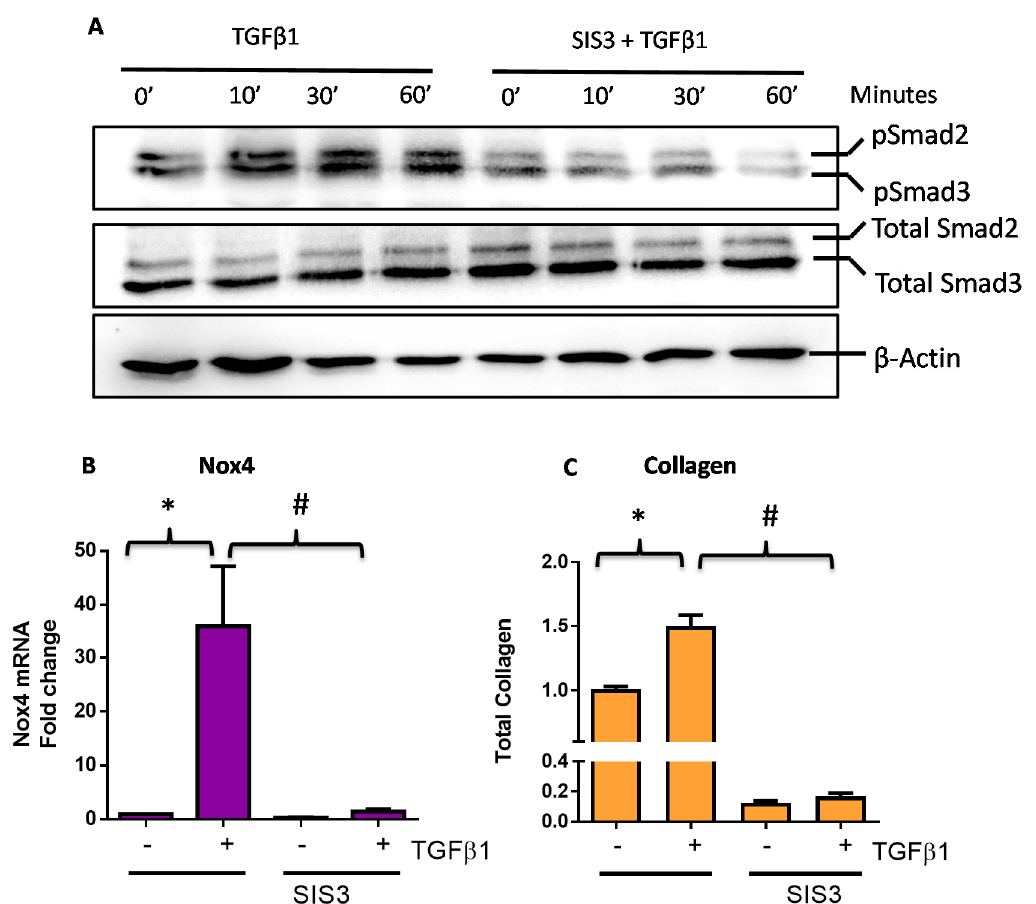
Figure 2. TGF β 1 responses are mediated via a Smad3-dependent pathway in human Tenon’s fibroblasts (HTFs). ( A ) A representative Western blot showing TGF β 1 (5 ng / mL) induced Smad3 phosphorylation in the absence and presence of a Smad3 inhibitor SIS3 (5 µ M). ( B ) Pre-treatment of Smad3 inhibitor SIS3 suppressed TGF β 1-induced ( B ) Nox4 gene expression (6 h) and ( C ) total collagen expression (24 h). All data are mean ± SEM from three to four independent experiments, * p < 0.05 from Ctrl without treatment; # p < 0.05 from cells treated with TGF β 1.